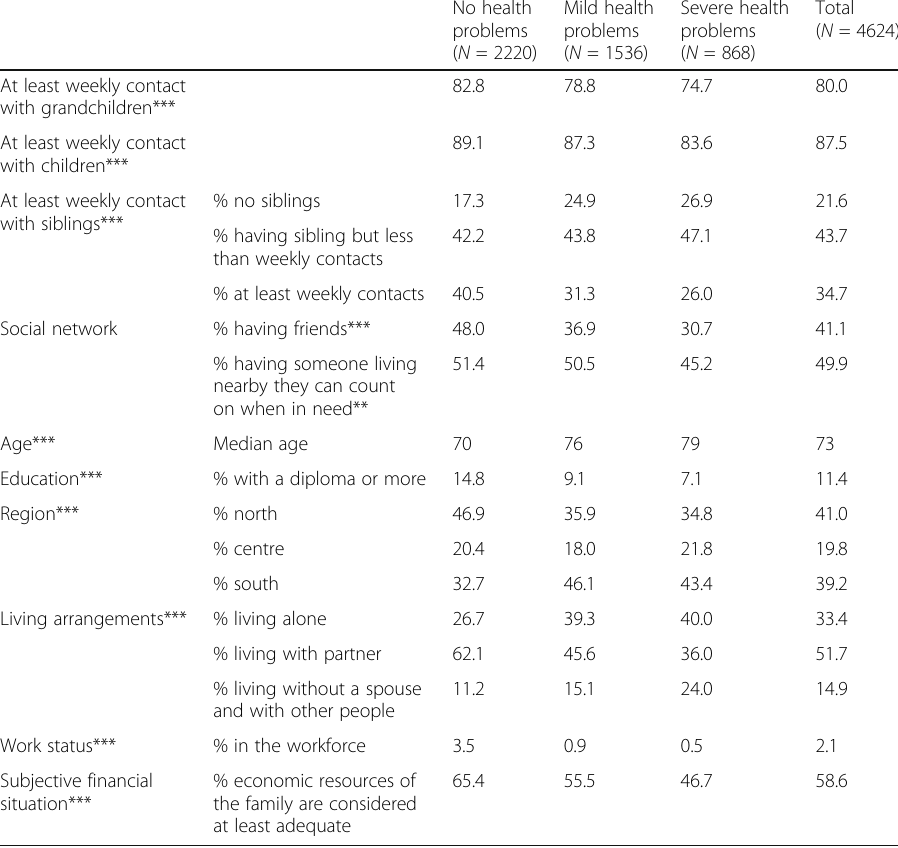
Table 4 Descriptive characteristics of grandmothers ≥ 60 years by the presence or absence of limitative health problems (data are expressed as a percentage, except for age) No health